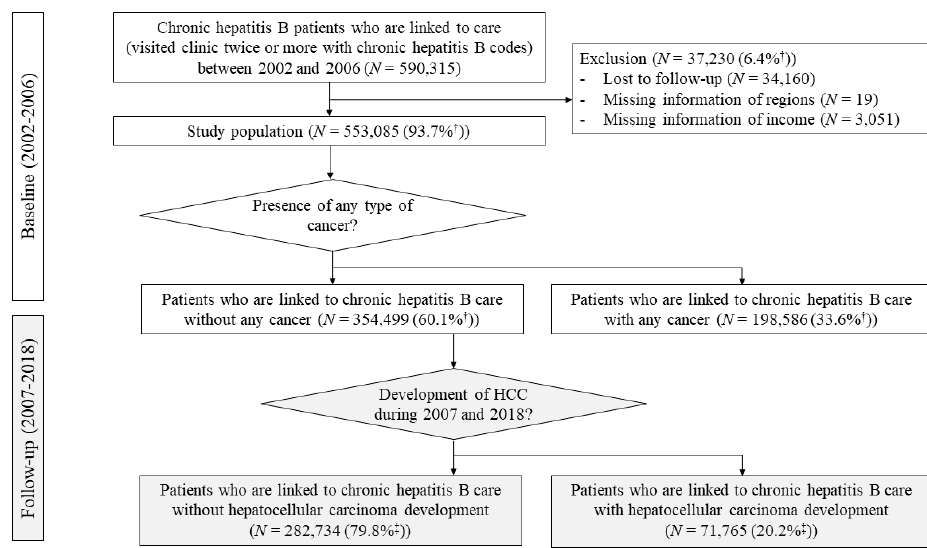
Figure 1. Flow diagram of the study population. CHB patients who were linked to care between 2002 and 2006 were identified at baseline. Those without any type of cancer were followed-up during 2007 and 2018. Twenty percent of linked-to-care CHB patients without any type of cancer showed hepatocellular carcinoma development during the follow-up period. The estimation of the linked-to-care population between 2002 and 2006 was based on the estimated reference chronic hepatitis B (CHB) data in 2005 in Korea. † Percentage was calculated as number of corresponding patients out of total linked-to-care CHB patients ( N = 590,315). ‡ Percentage was calculated as number of corresponding patients out of linked-to-care CHB patients without any type of cancer at baseline ( N = 354,499).